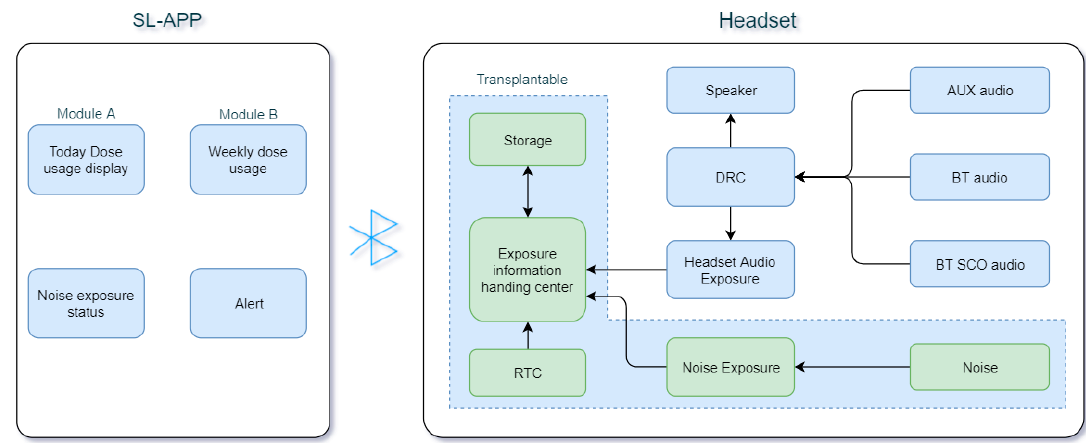
Figure 3. Safe listening software architecture in PLD.